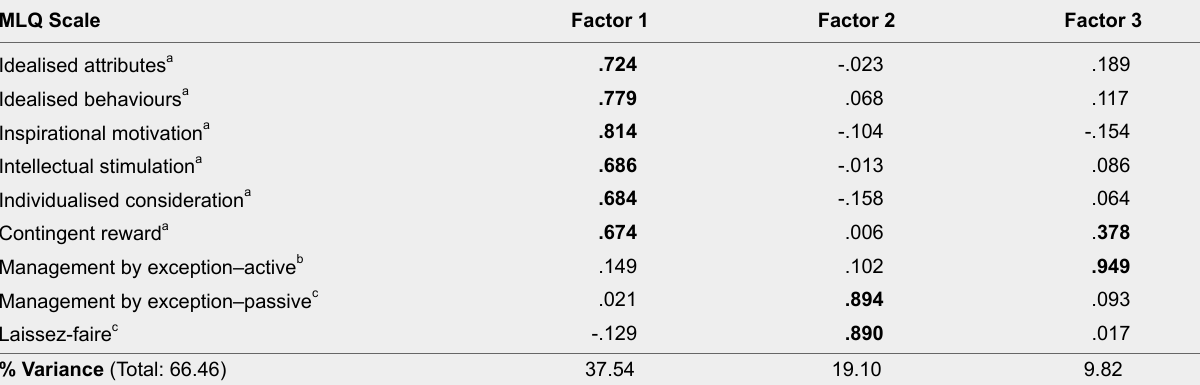
Rotated Factor Matrix for the Factor Analysis of the MLQ Leadership Behaviour